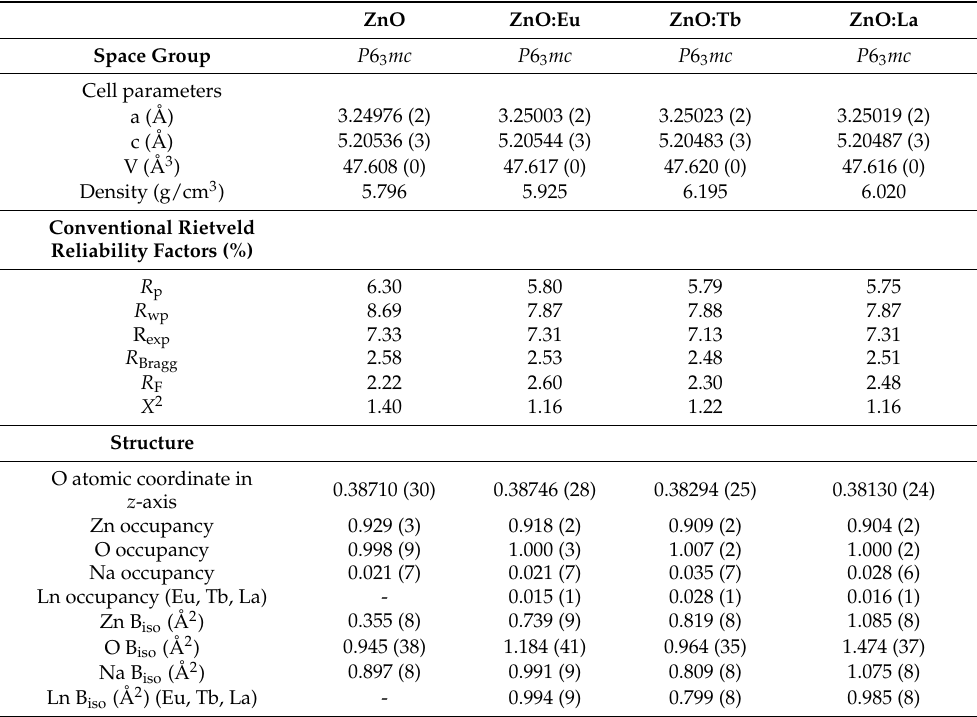
Figure 7. Rietveld refinement of ZnO, ZnO:Eu, ZnO:Tb, and ZnO:La samples. Experimental X-ray powder diffraction pattern is indicated by red dots, Rietveld-calculated profile by the black solid line and the difference between the observed and calculated patterns by the blue curve. Green vertical markers represent the calculated Bragg reflections of ZnO. Cell structural refined parameters are summarized in Table 3. Selected bond distances and angles, domain size and average maximum strain are listed in Tables S3 and S4. From Table 3. Cell parameters, conventional Rietveld reliability factors, and structural parameters obtained from Rietveld refinements of ZnO, ZnO:Eu, ZnO:Tb, and